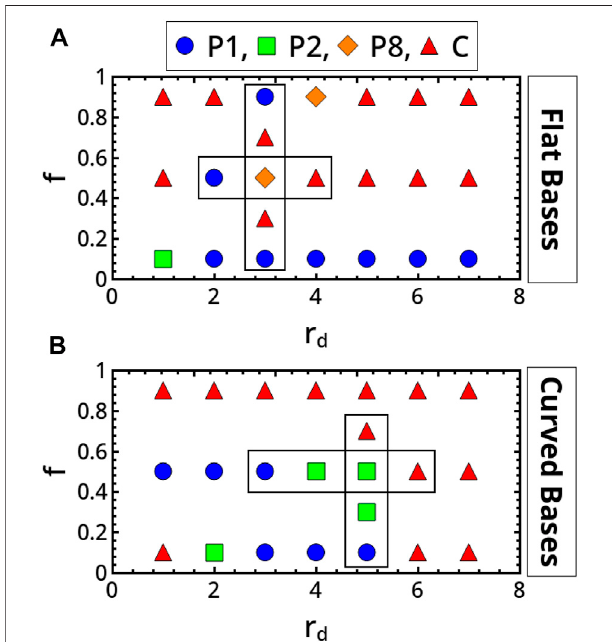
FIGURE 2 | Classi fi cation in the parameter spaces spanning the restitution coef fi cient, f , and the disc radius, r d, of the main scenarios characterizing the milling body dynamics in fl at-base (A) and curved-base (B) geometries. P1, P2, P8 and C identify period-1, period-2, period-8 and chaotic regimes,